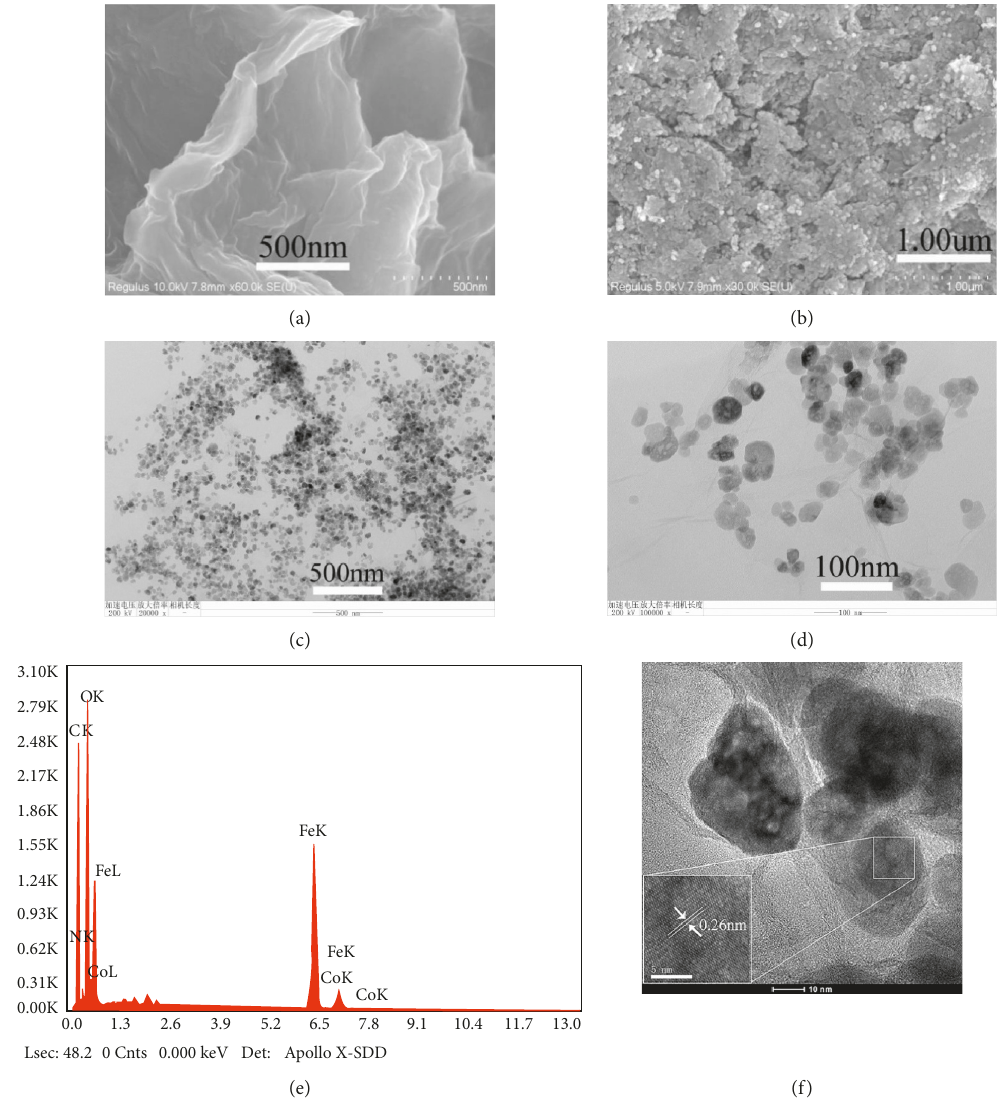
Figure 1: (a, b) SEM images of GO and TGOM; (c, d) TEM images of TGOM; (e) EDS of TGOM; (f) HR-TEM image of